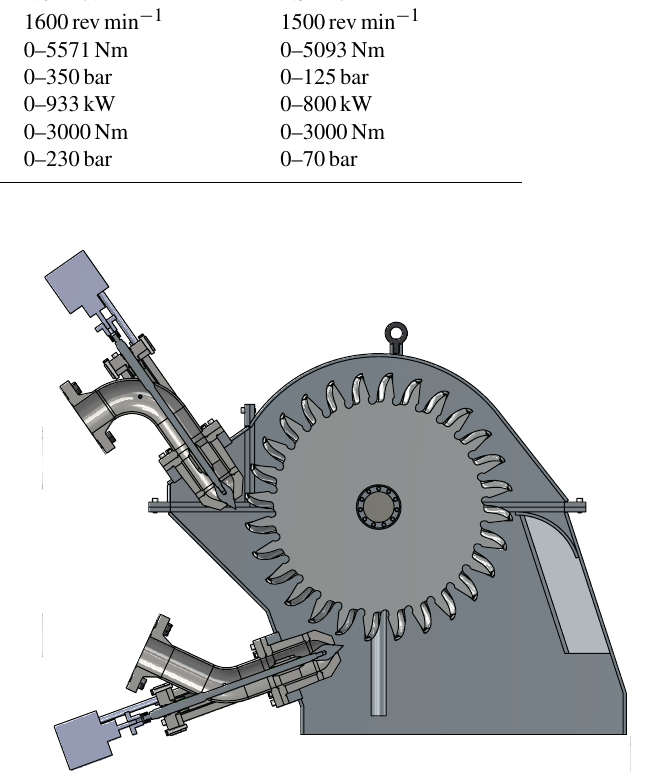
Figure 4. The pressurized hydrostatic water flow is converted to a hydrodynamic water jet using spear valves. The high-speed jets exert a force on the buckets of the Pelton